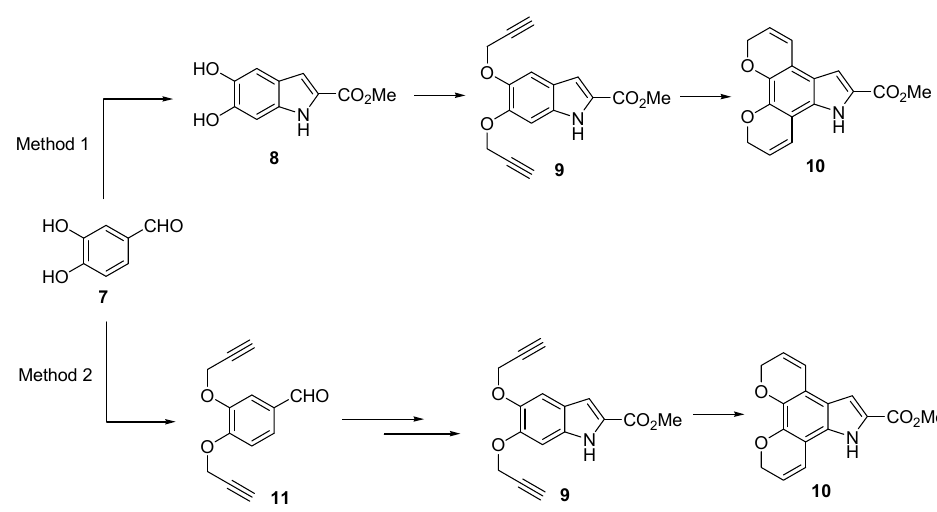
Figure 2. Two methods for the preparation of pyranoindole systems.